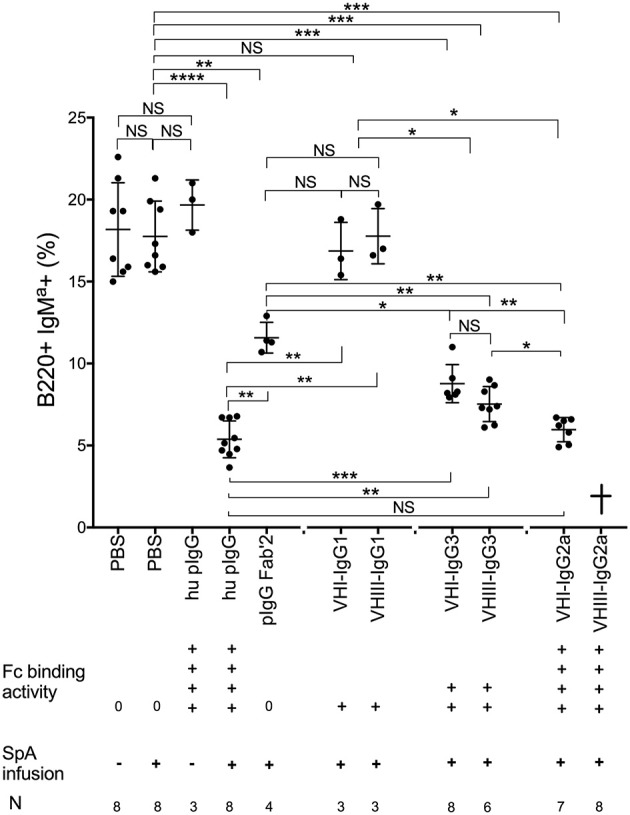
Extent of in vivo SpA-mediated B cell depletion reflects in vitro binding affinity. Assessment of SpA mediated depletion of transgenic T15i (+/−) B-cells following sham pretreatment or pretreatment with human polyclonal IgG (hu pIgG) or human polyclonal IgG F(ab)'2 (pIgG Fab'2) or monoclonal murine IgG, as indicated. At 72 h after SpA (or sham) treatment, levels of residual T15i B cells are indicated for individual mice. Results represent residual splenic IgMa + B cells, after gating on adoptively transferred CFSE-labeled mononuclear cells, that identified only the B220+ IgMa+ Cells. After VHIII Fab IgG2a treatment, all mice died acutely () and residual B cells could therefore not be quantitated. Mann-Whitney test, *p < 0.05, **p < 0.005, ***p < 0.001, ****p < 0.0001. NS, not significant. Binding activity data of murine IgG isotypes were from Wikipedia.